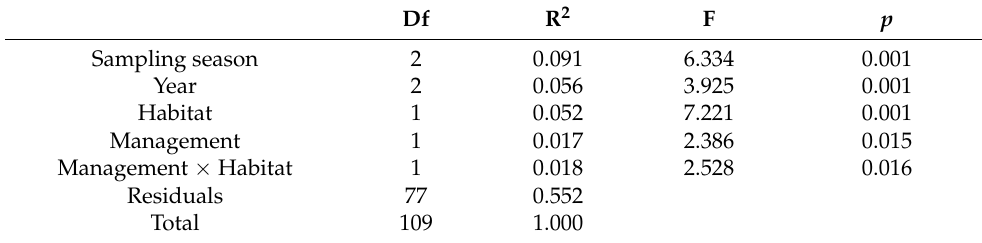
Table 2. Results of a PERMANOVA test showing the effect and variance explained by explanatory variables on the community composition of dominant parasitoid morphospecies in the vineyards, from 2016 to 2018. Main effects are listed by decreasing R 2 . Only significant effects ( p < 0.05) are